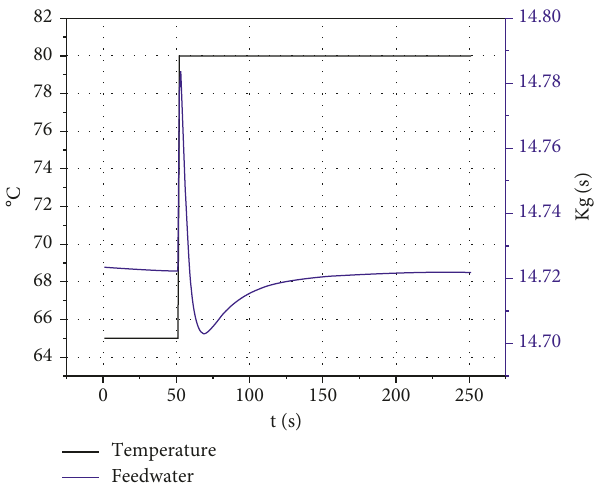
Figure 14: Simulation curves of feedwater flow and feedwater temperature.